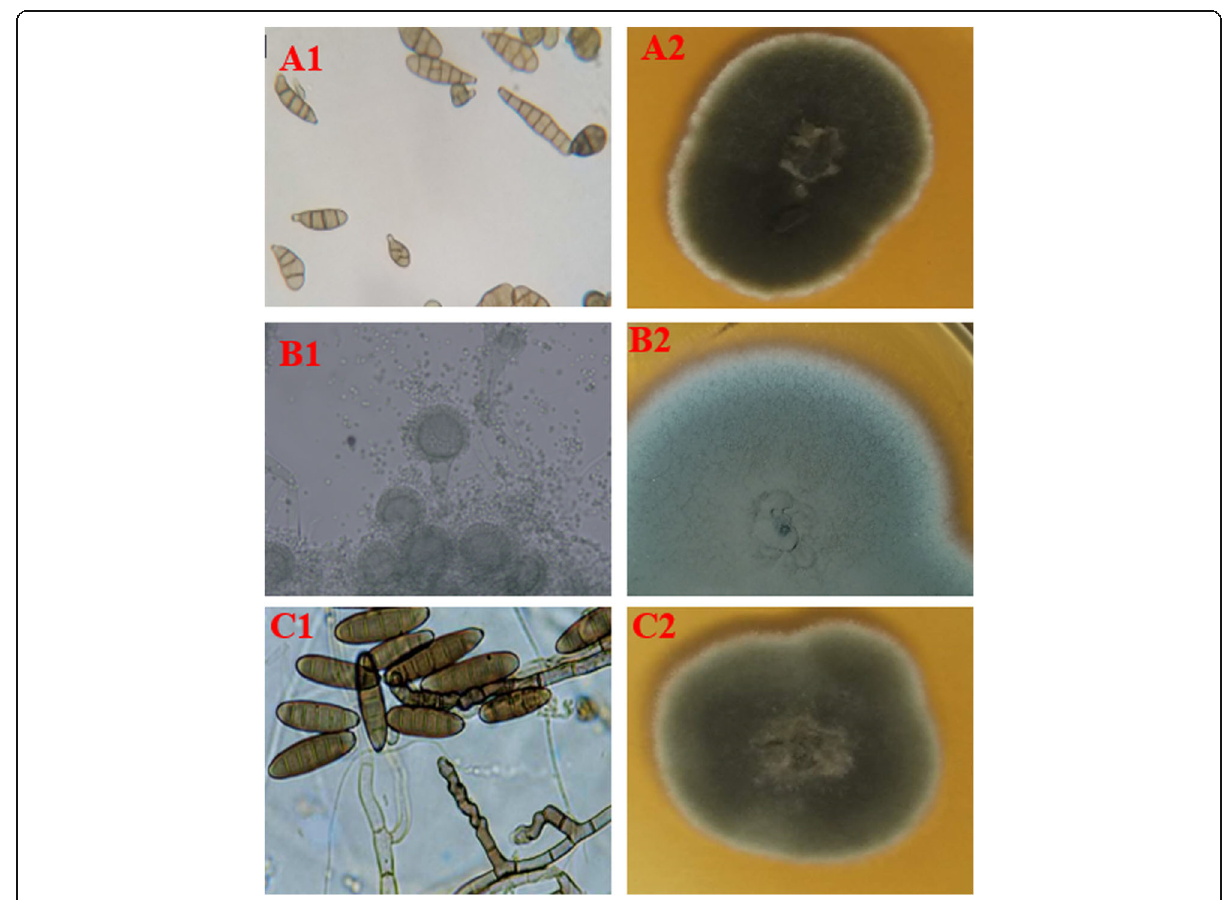
Fig. 1 Microscopic (1) and fungal colony characterization (2) of endophytic fungi isolated from P. hysterophorus . (A) Alternaria spp., (B) Aspergillus spp., (C) Drechslera